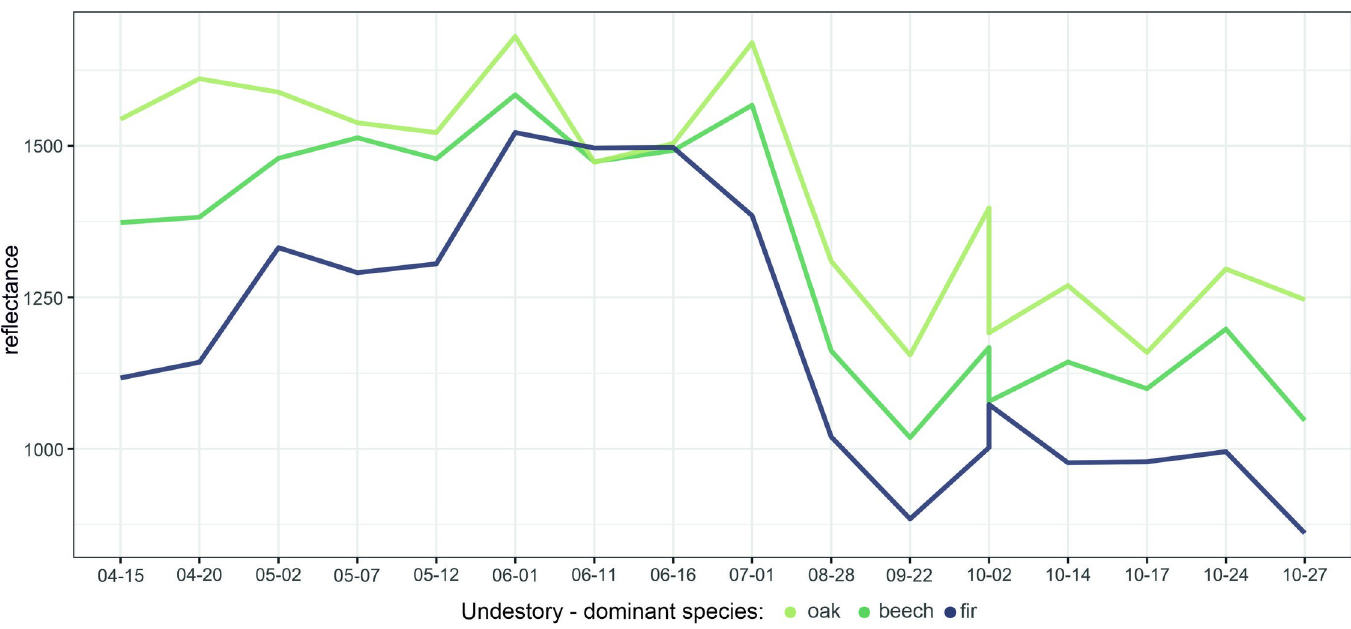
Fig 8. Scots pine stands reflectance in SWIR1 band depending on dominant understory